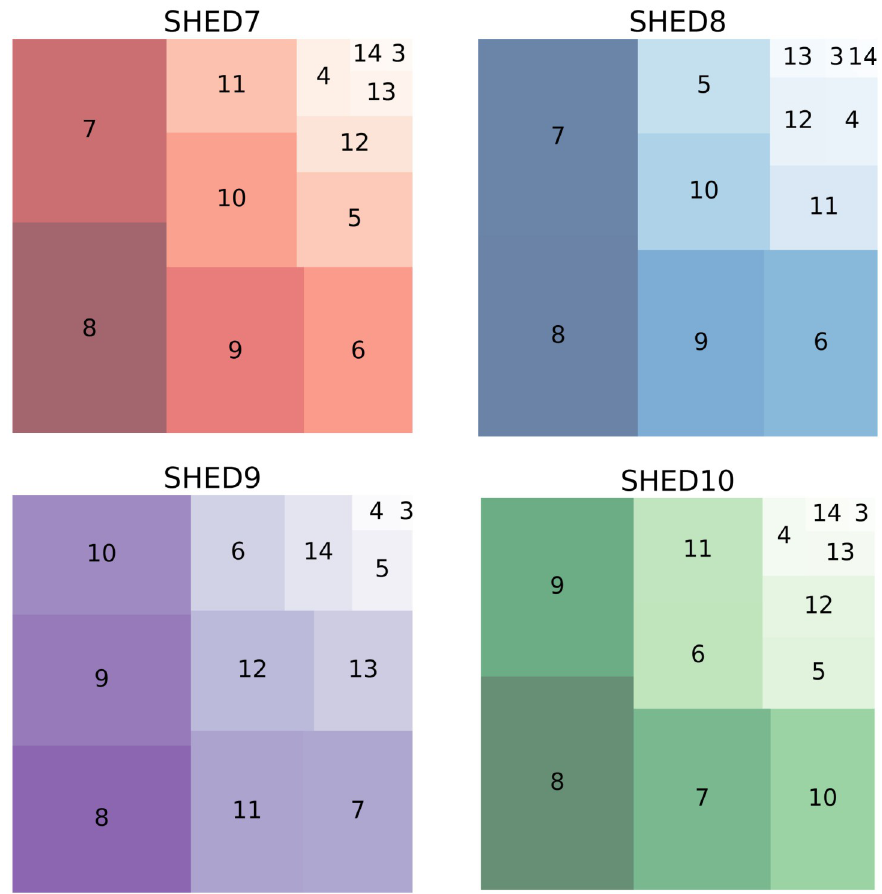
Fig 4. TreeMap of nodes with data per